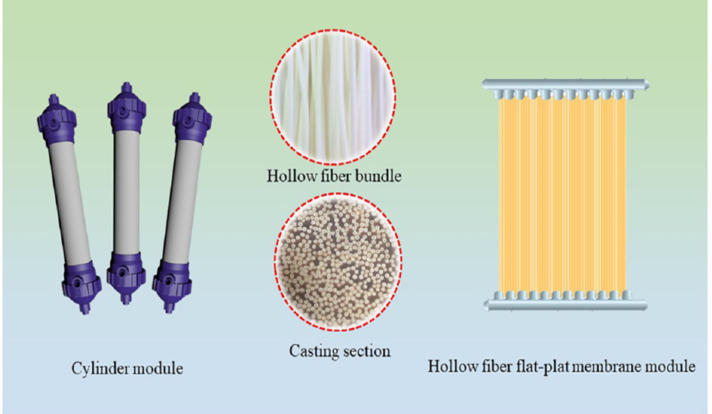
Figure 14. Commercial HF membrane module type [210]. Reprinted/adapted with permission from Ref. [210]. Copyright 2022,